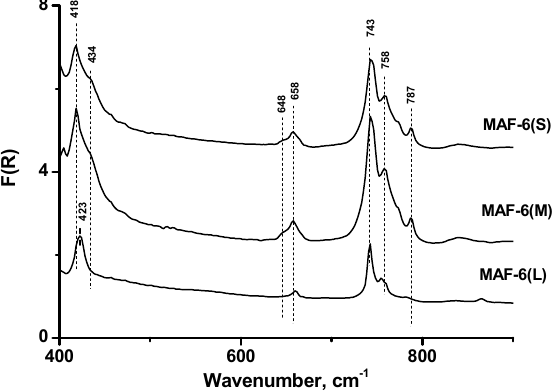
Figure 3. DRIFT spectra of MAF-6 with different particle sizes.